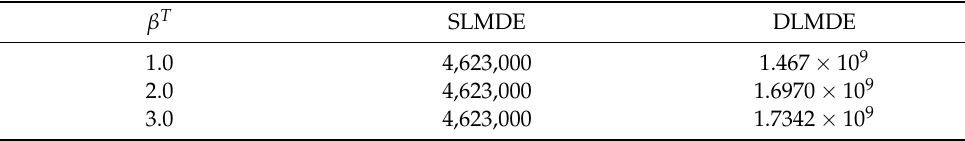
Table 8. Number of function evaluations required by both methods for car side impact